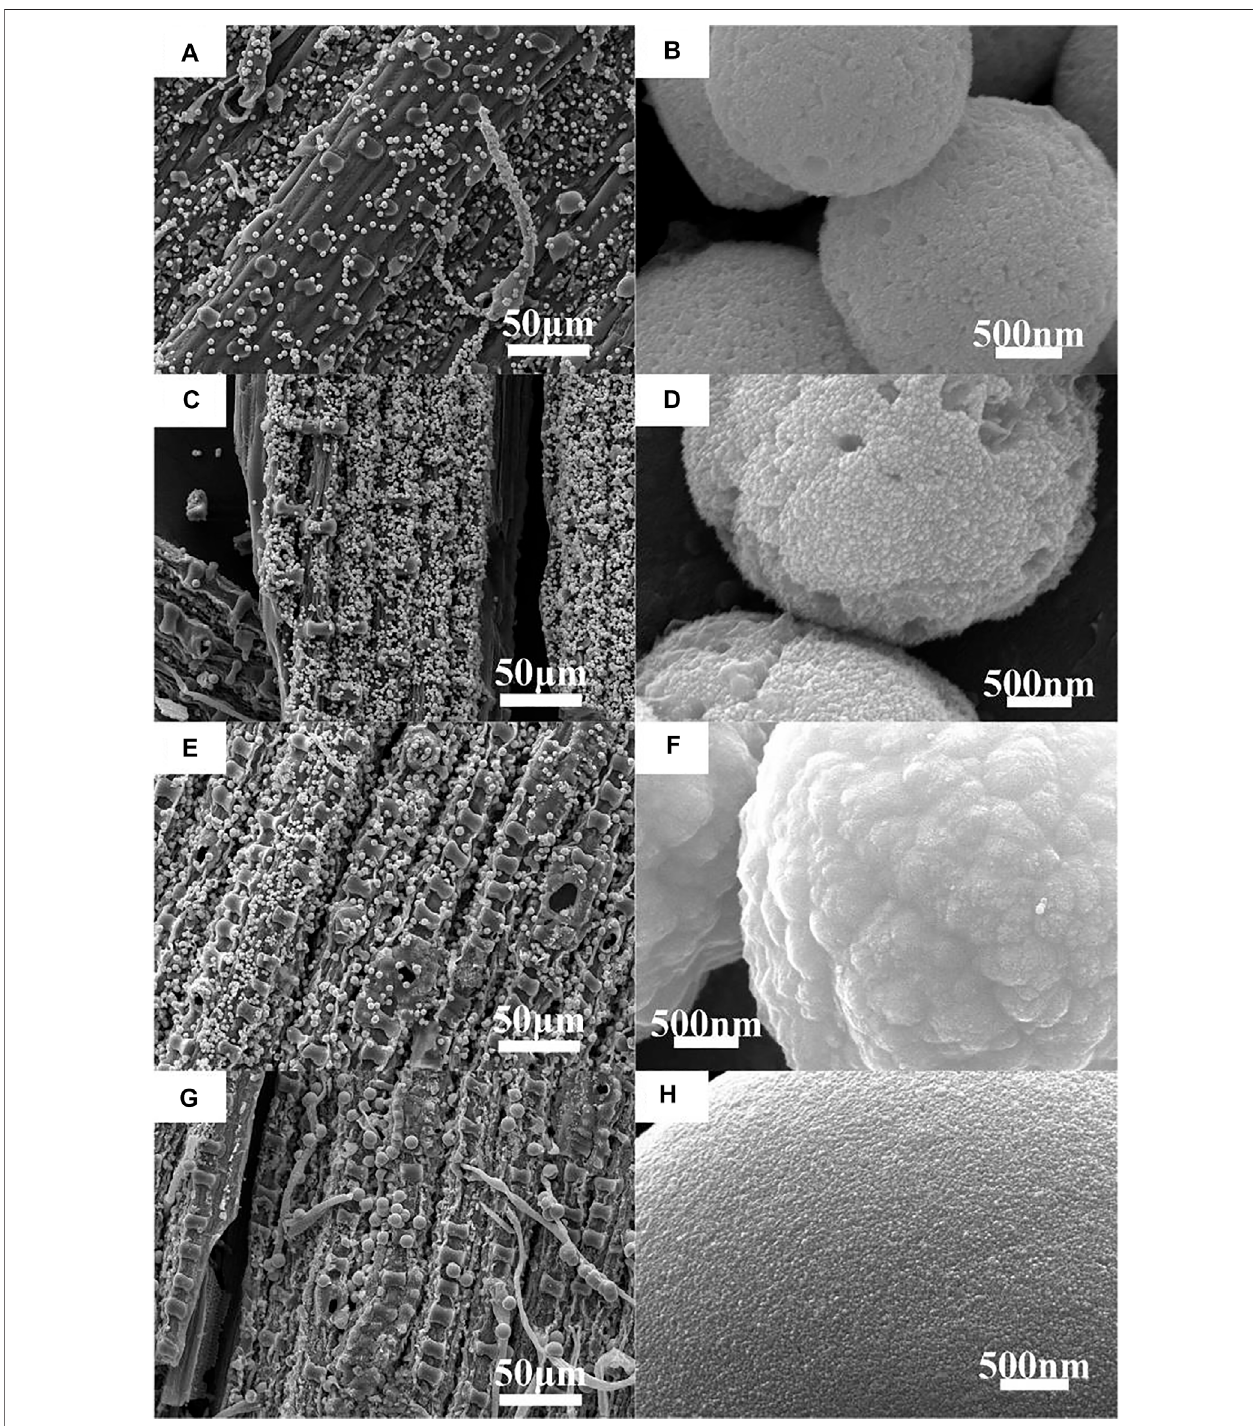
FIGURE 2 | SEM images and enlarged SEM images of MoS 2 /C composites with the different concentrations of molybdenum chloride prepared by the hydrothermal calcination method. (A,B) 0.05 mol/L, (C,D) 0.10 mol/L, (E,F) 0.15 mol/L, and (G,H) 0.20 mol/L.